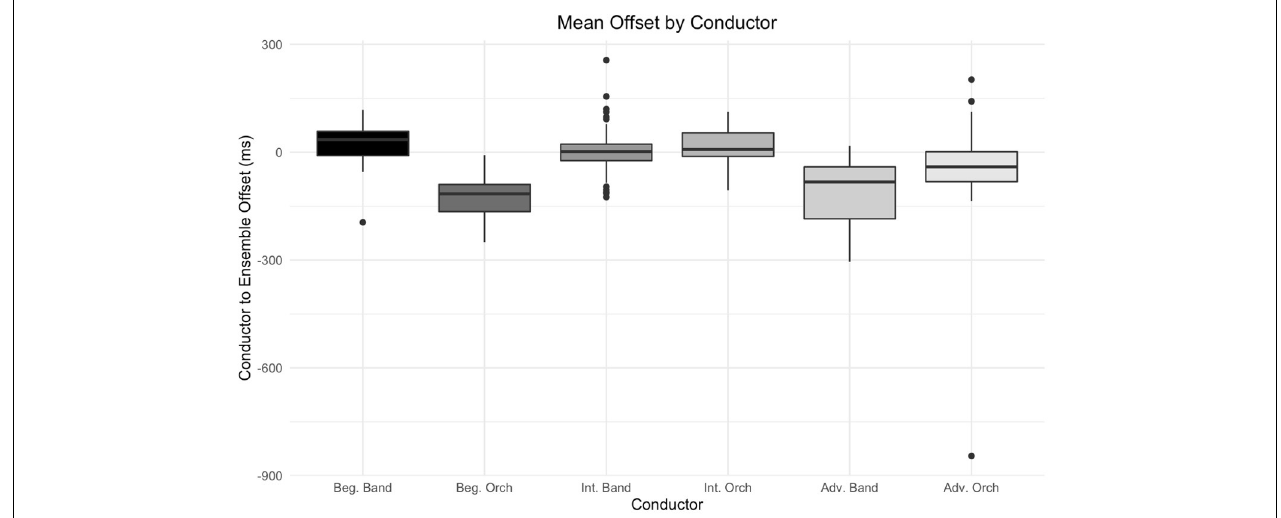
FIGURE 5 | Mean offsets by conductor. Mean offset values by conductor. Significant differences were found between conductors overall, but not between like-ensemble intermediate and advanced